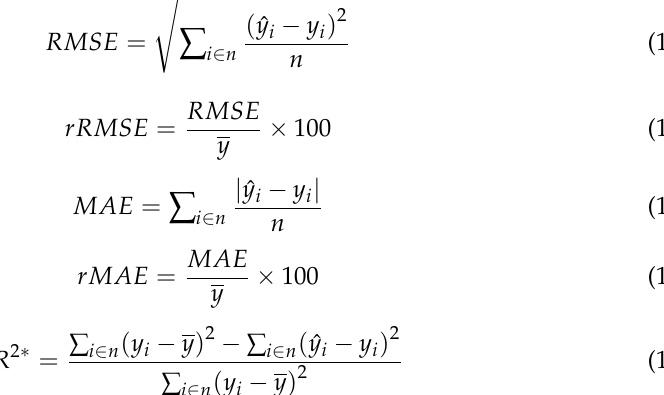
), initial value of upper canopy height (cid:101) γ